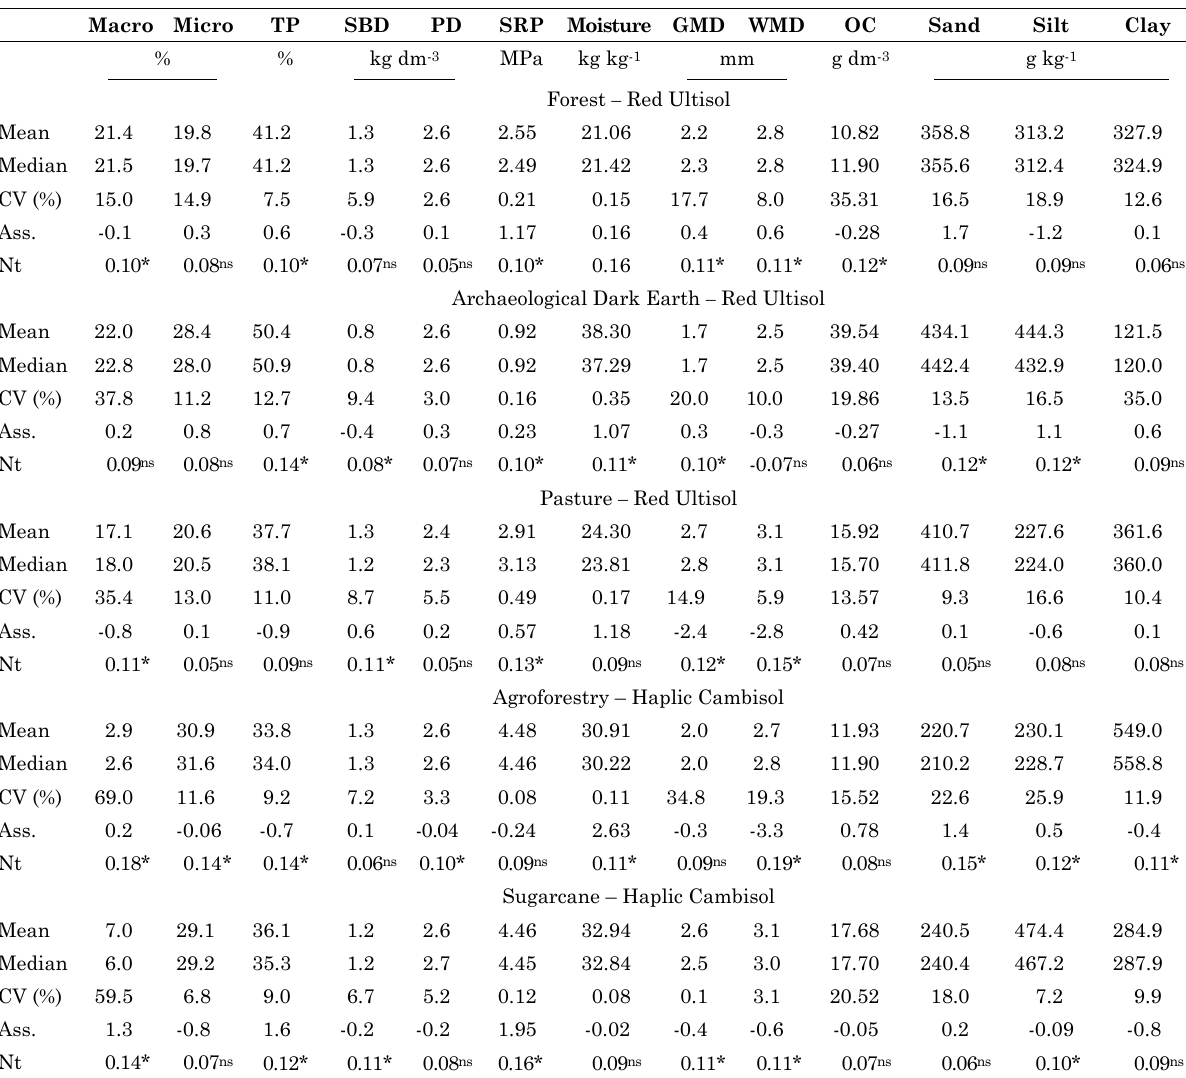
Table 2. Descriptive statistics for soil physical attributes in the municipalities of Humaitá and Manicoré in the south of